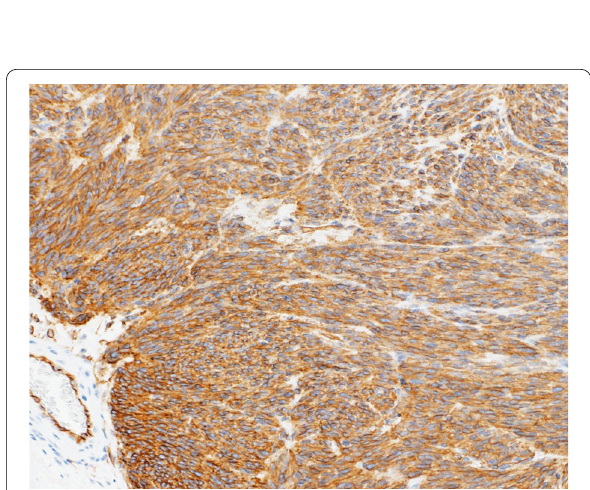
100). Nodular Fig. 8 Positive immunostaining for CD34 (magnification × indicated a gastrointestinal stromal tumor